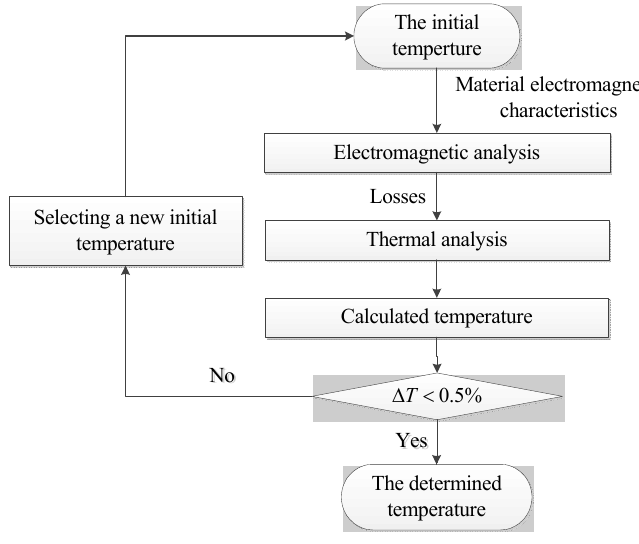
Figure 19. Flow diagram of electromagnetic and thermal iteration.